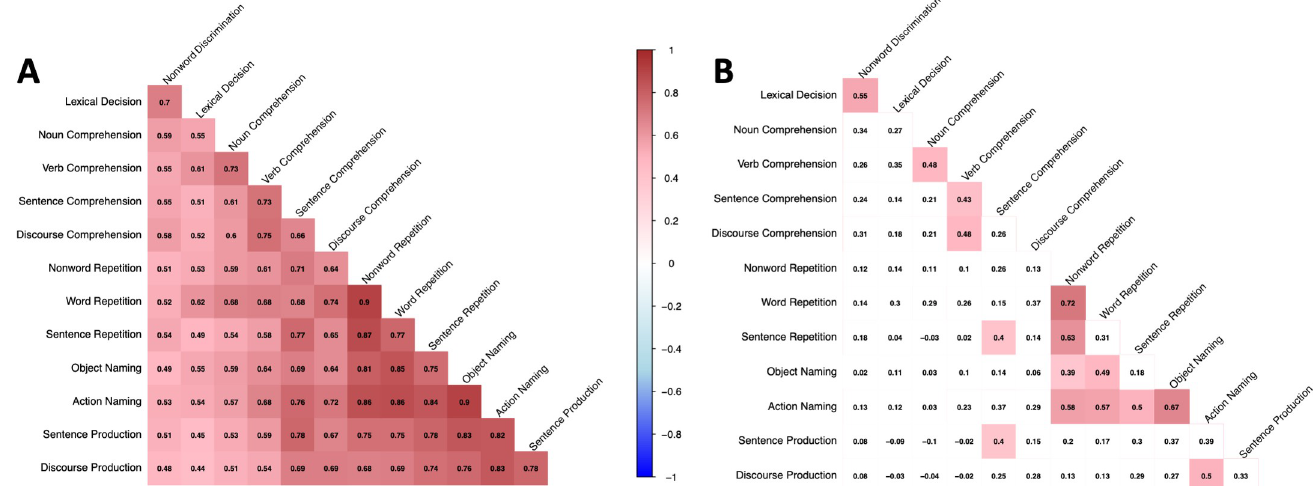
Fig 5. Correlation between the subtests’ scores. Panel A–simple Pearson correlations between the RAT subtests without accounting for aphasia severity. Panel B– partial Pearson correlations between the RAT subtests accounting for overall aphasia severity as measured independently by the total score on the Assessment of Speech in Aphasia (ASA). The plotted correlations are based on complete pairwise observations. The Bonferroni-corrected p -value equals .05 / 78 = 0.0006. Tiles with significant correlations are highlighted.